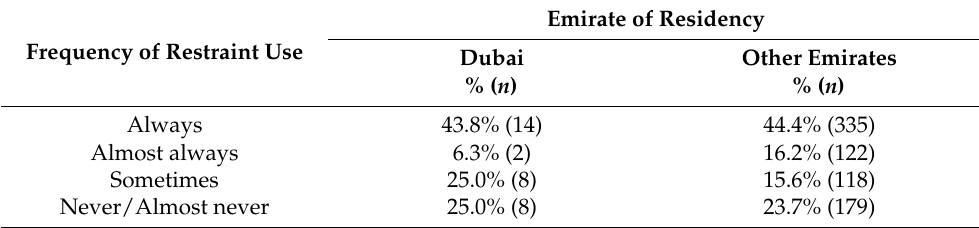
Table 7. Participants’ Emirate of residency and frequency of restraint use for their eldest